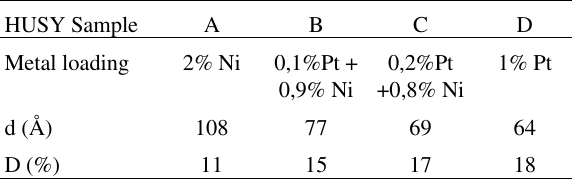
Table 1. Metal particle size and dispersion of the